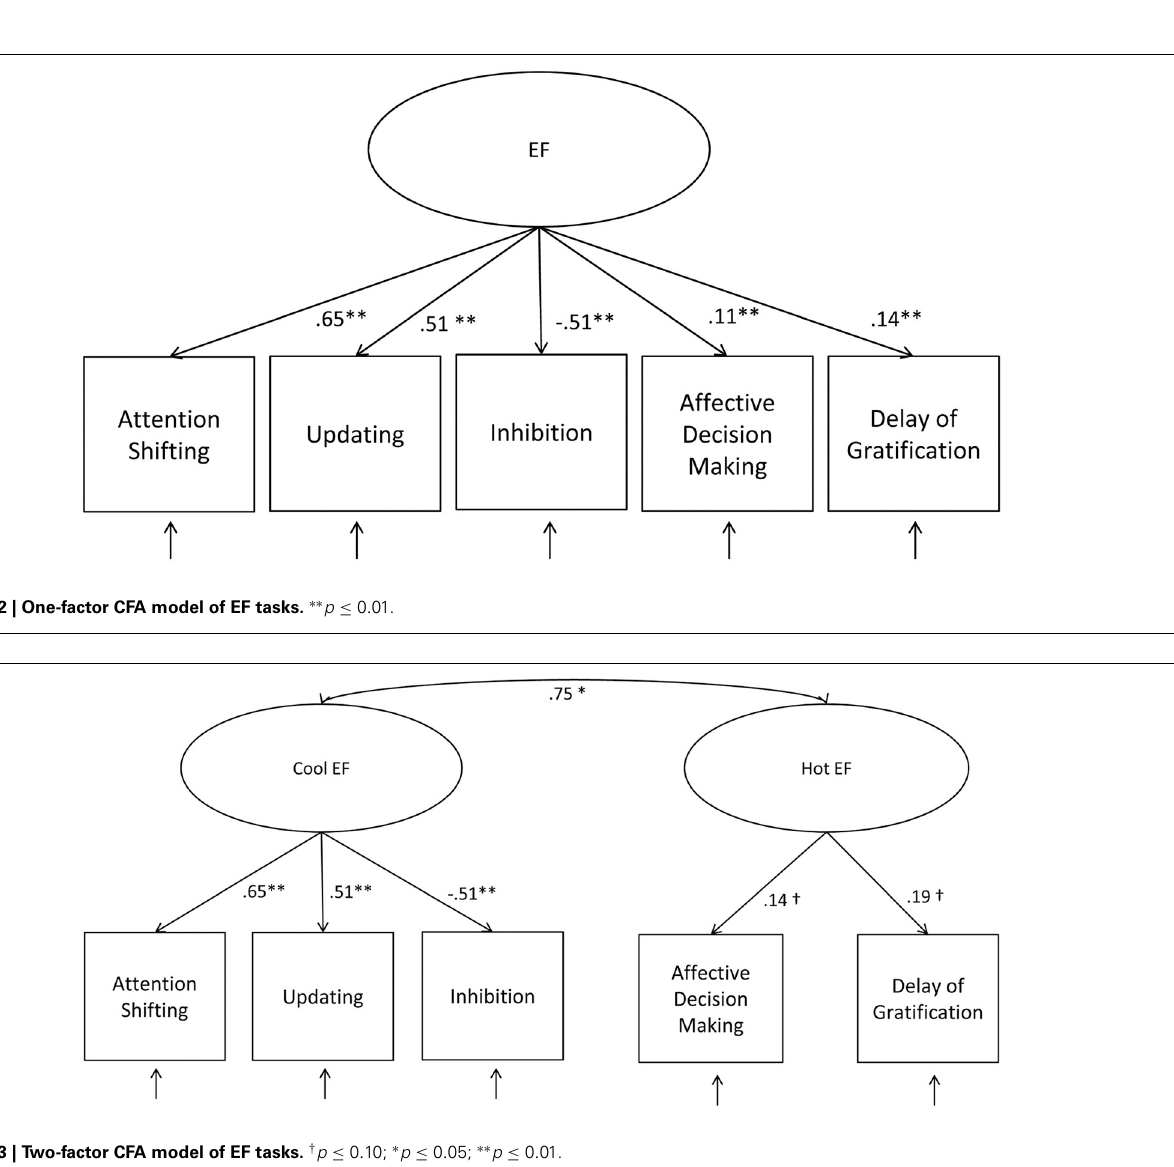
FIGURE 3 | Two-factor CFA model of EF tasks. † p ≤ 0 . 10; ∗ p ≤ 0 . 05; ∗∗ p ≤ 0 .